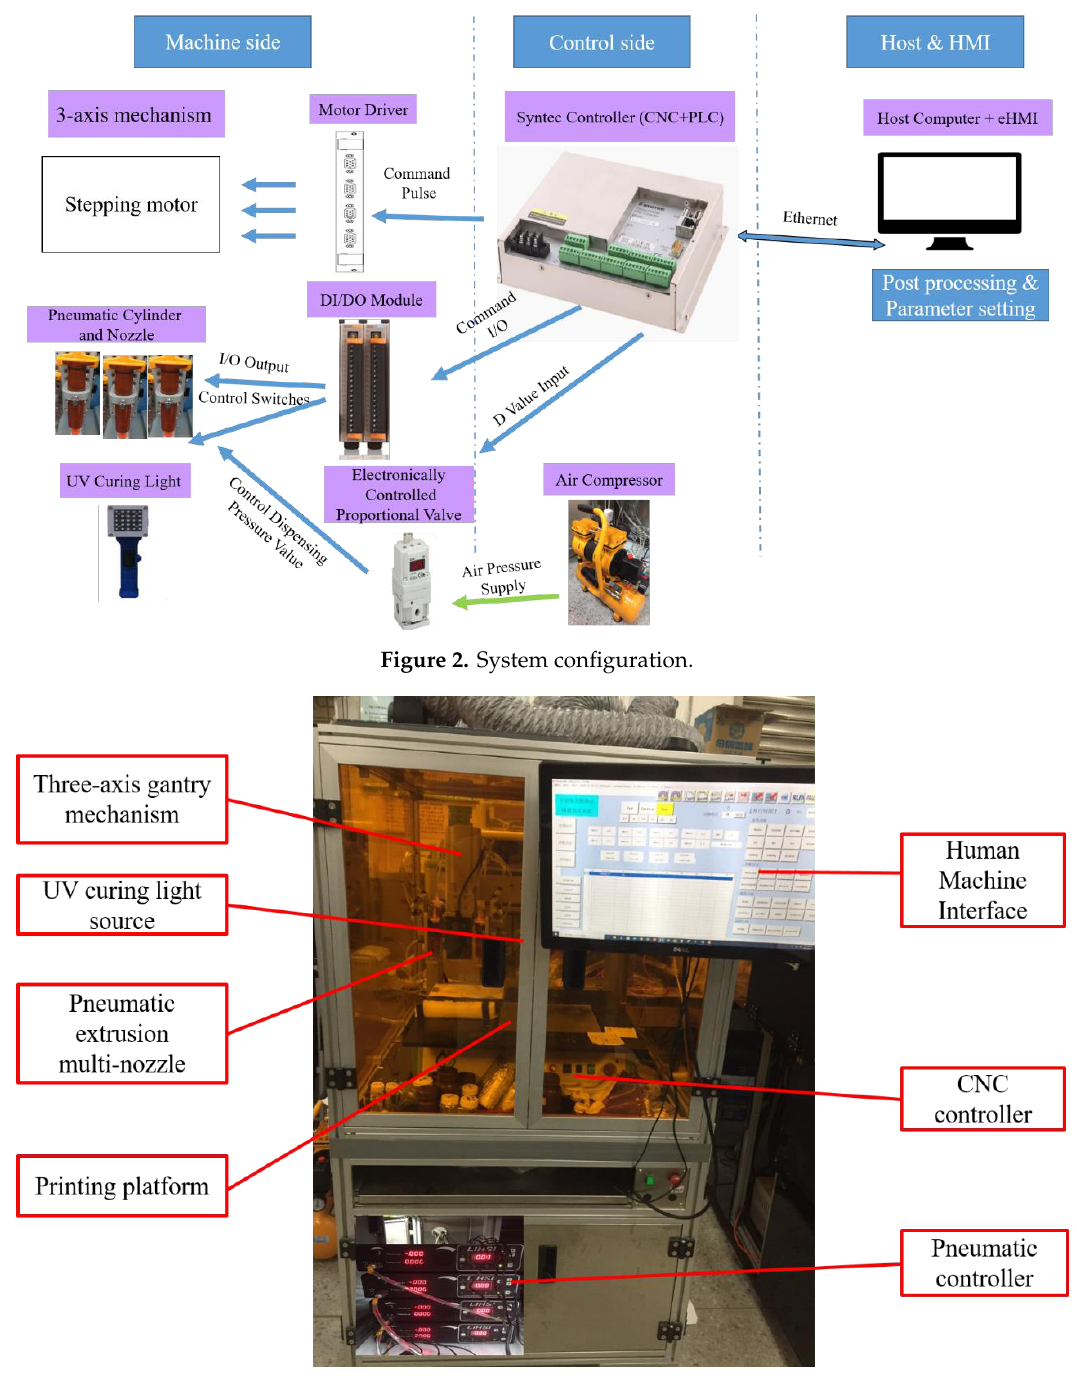
Figure 3. A photo of the hardware system architecture.